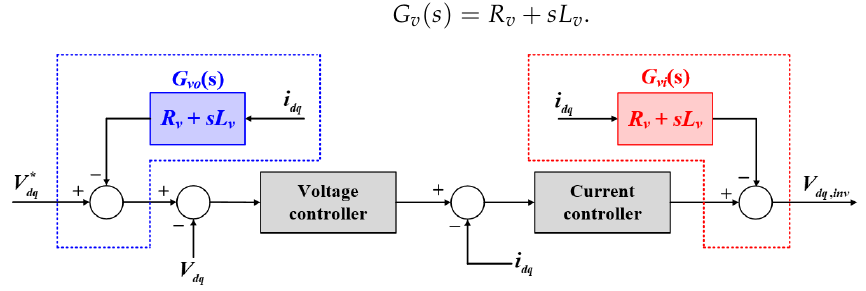
Figure 4. General implementation form of the outer and inner virtual impedance.